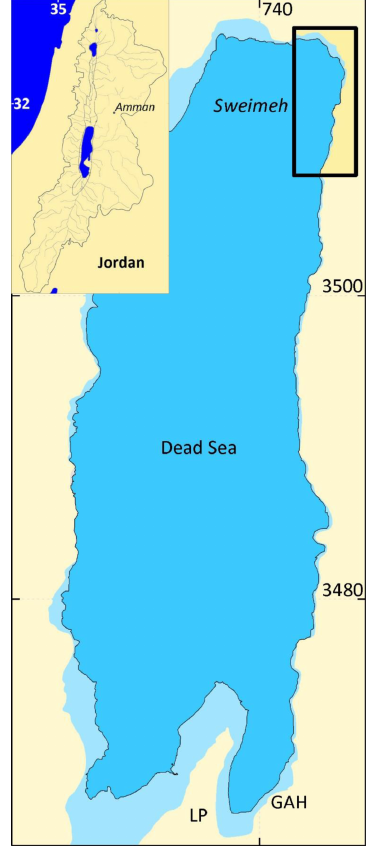
Figure 1. Inset: the Dead Sea watershed (coordinates in degrees). Main map: location and extent of the Dead Sea. The study area (Sweimeh) is located in the north-east (black box). The extent of the lake in the 1960s appears in light blue colour. The black line indi- cates the shoreline in 2018. In the south are located two main sink- hole sites: the Lisan Peninsula (LP) and Ghor Al-Haditha (GAH) (coordinates in UTM 36 (km), WGS